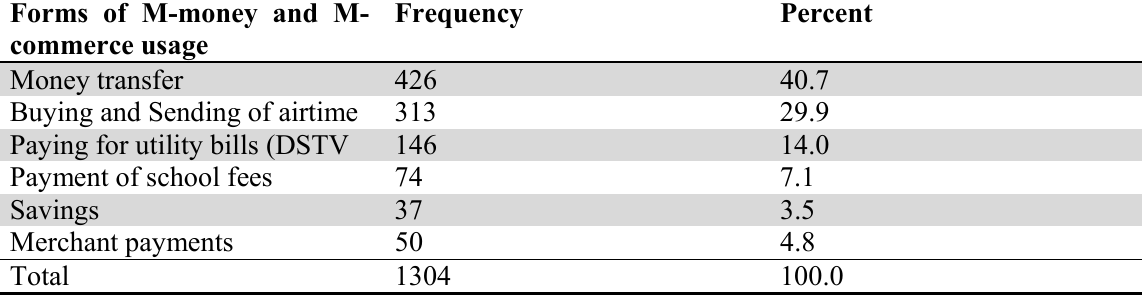
Forms of M-money and M-commerce usage